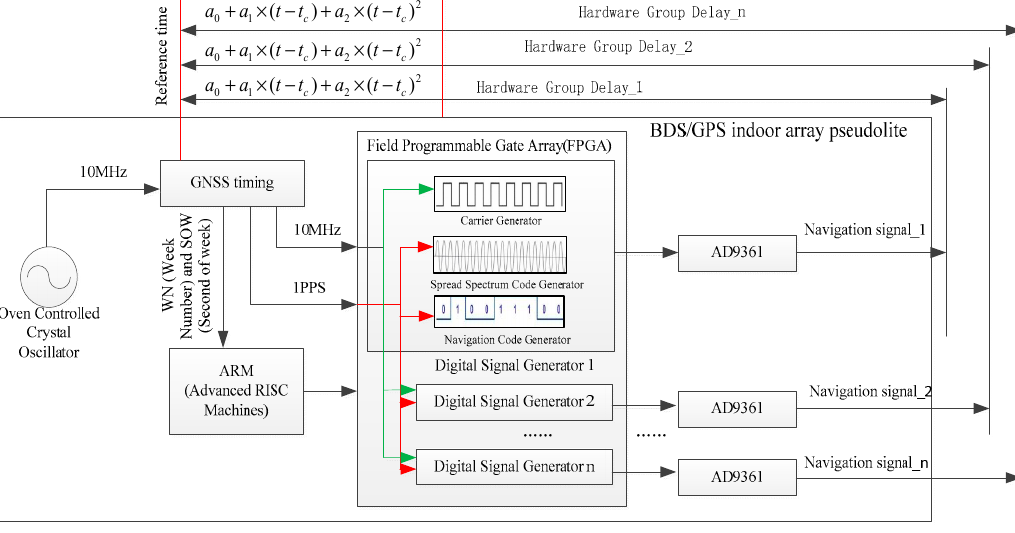
Figure 2. Time synchronization method of BDS/GPS indoor array pseudolite. GNSS: Global Satellite Navigation System.